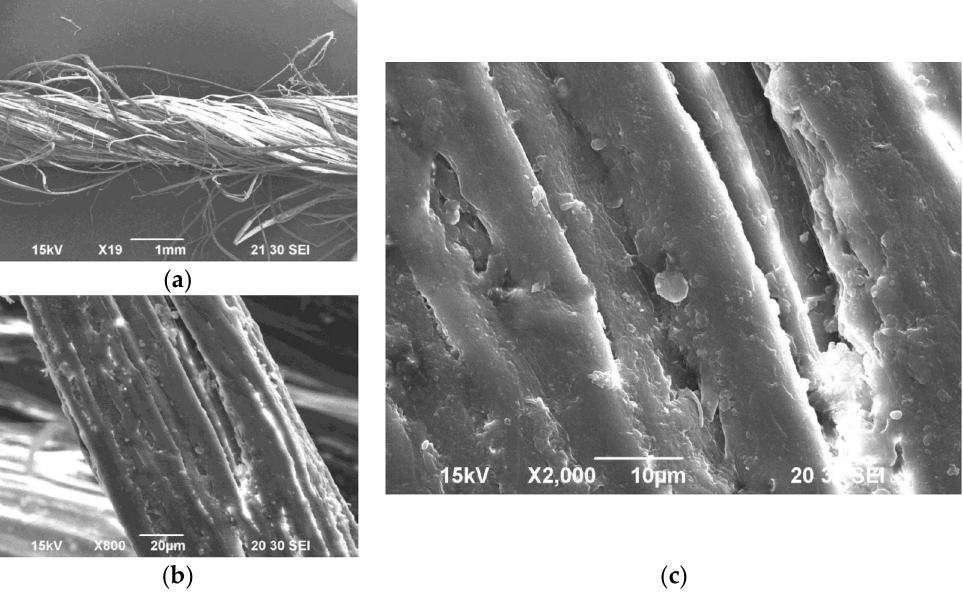
Figure 3. Magnified View of a jute yarn specimen. ( a ) A section of yarn; ( b ) A fiber in the yarn; ( c ) The surface of a fiber in the yarn.